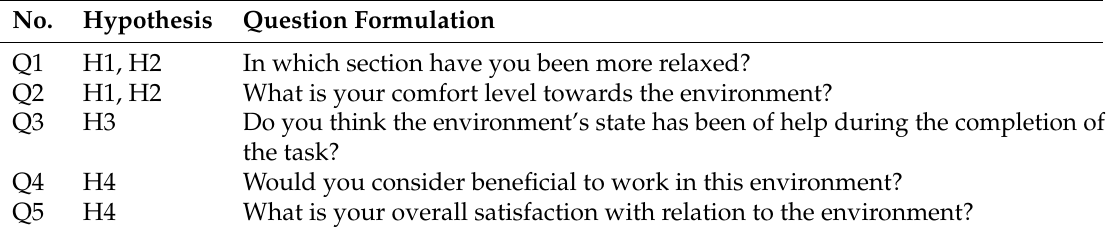
Table 4. Questions raised to the participants at the end of the